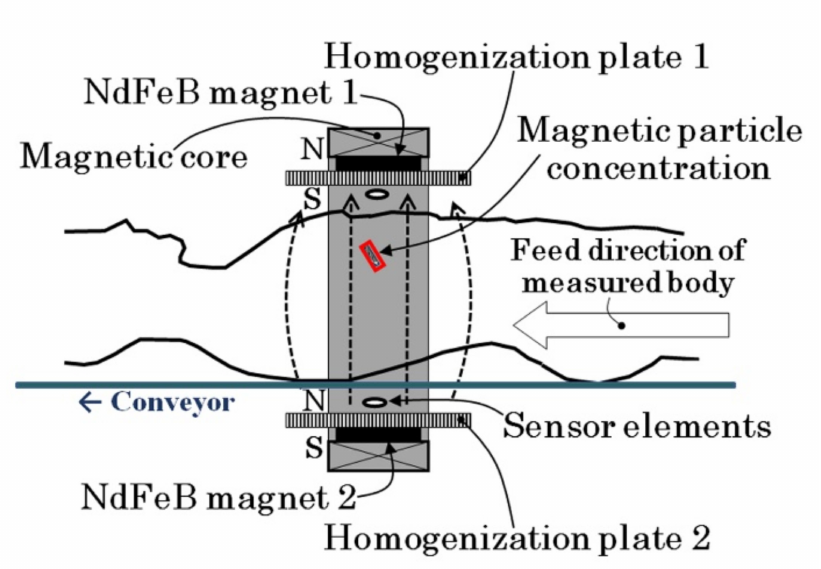
Figure 2 is an image of the measurement of a human body using the proposed in- spection system. A cluster of magnetic particles is magnetized by the generated uniform and constant directional field, and an array of magnetic sensors which are set inside the magnetic field is able to detect the field coming from the magnetized particle cluster. This system offers the advantage of detecting low-remanence magnetic particles due to the fact that the sensor measures the magnetic particles simultaneously with the magnetization inside the strong magnetic field. In this system, the magnetic sensor is a thin-film sensor in which the sensing direction is along the direction of the film plane, and which sets it in the uniform and constant directional strong magnetic field with the sensing direction set perpendicular to the magnetic field. The sensor works by retaining high sensitivity even in such a strong magnetic field due to the property of tolerance against the surface of the normal magnetic field. Based on our previous study, the position estimation of the small magnetic piece was realized using a measurement system which possesses the same structure shown in Figure 2.